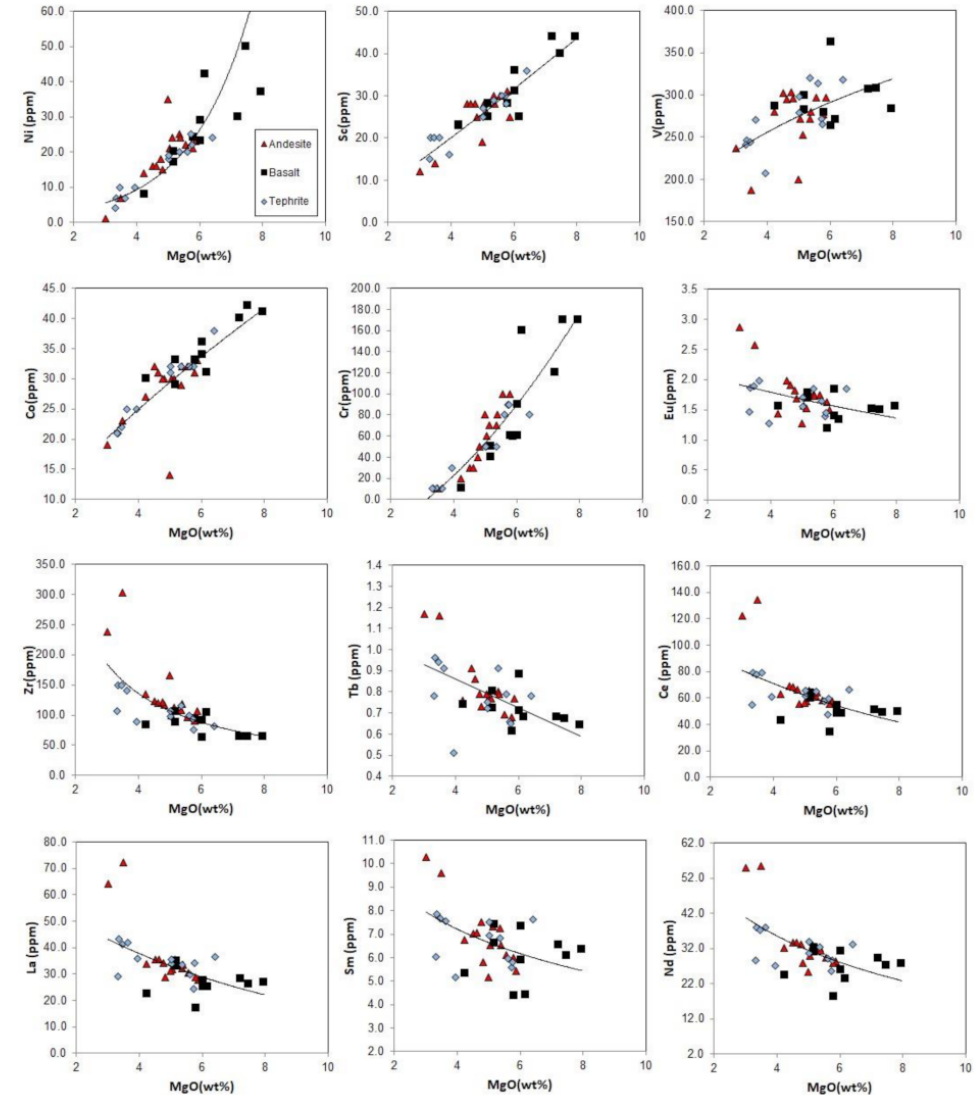
Figure 7. Geochemical variation diagram for Ni, Sc, V, Co, Cr, Eu, Zr, Tb, Ce, La, Sm and Nd elements against MgO.